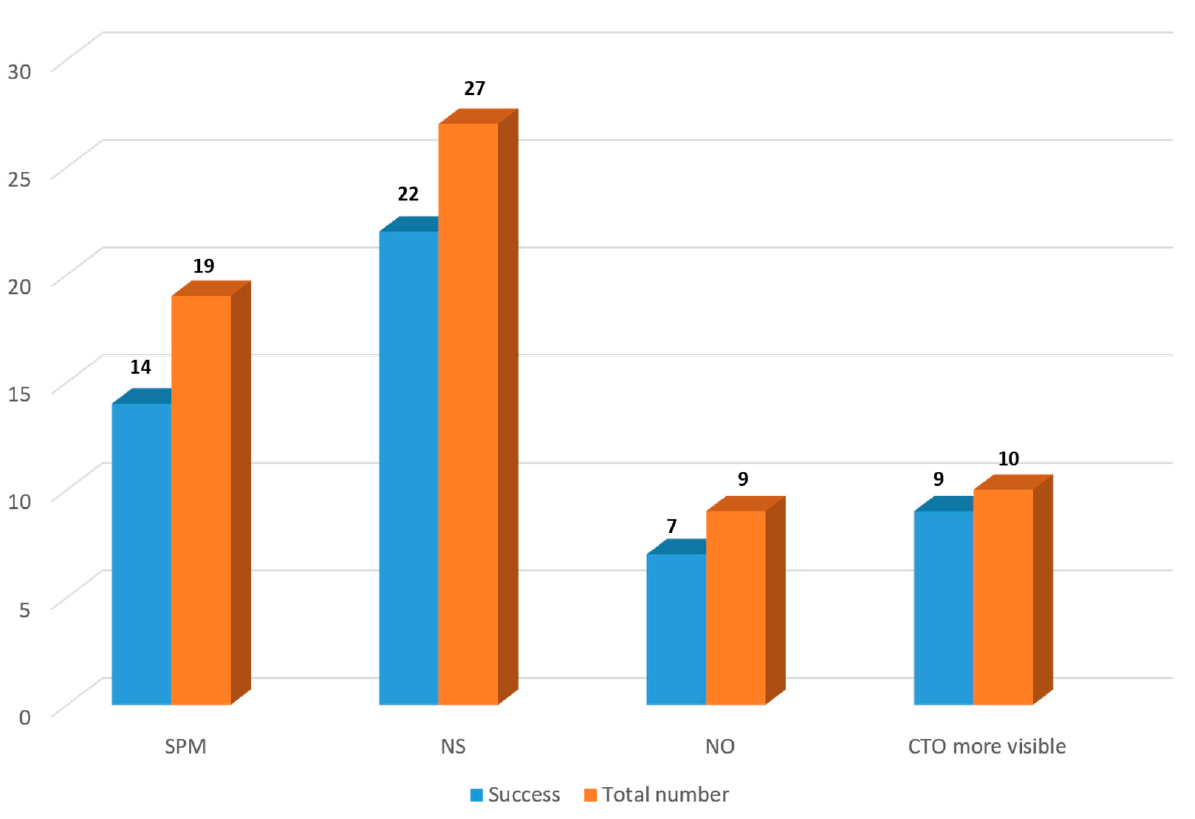
Figure 2. CTO-PCI success rate in different subgroups: SPM in the previous attempt, the use of new strategy, procedure performed by a new operator and based on more visibility of CTO body in the new attempt. CTO: chronic total occlusion; NO: new operator; NS: new strategy; SPM: subintimal plaque modification (during the previous failed attempt). Table 4. Procedural approach and outcome of reattempted